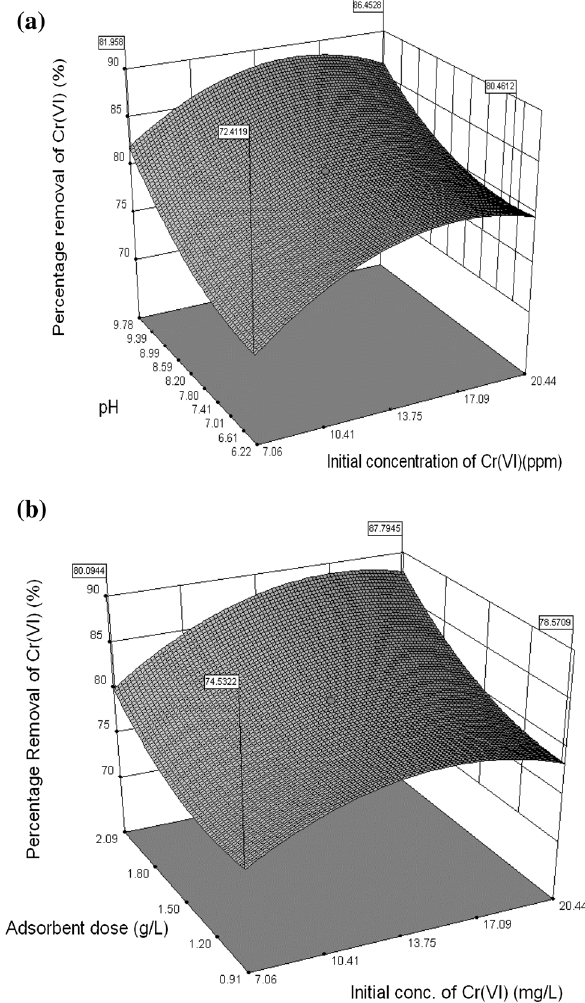
Fig. 10 a Conjugate effect of pH and initial concentration on percent- age removal and b conjugate effect of adsorbent dose and initial con- centration on percentage